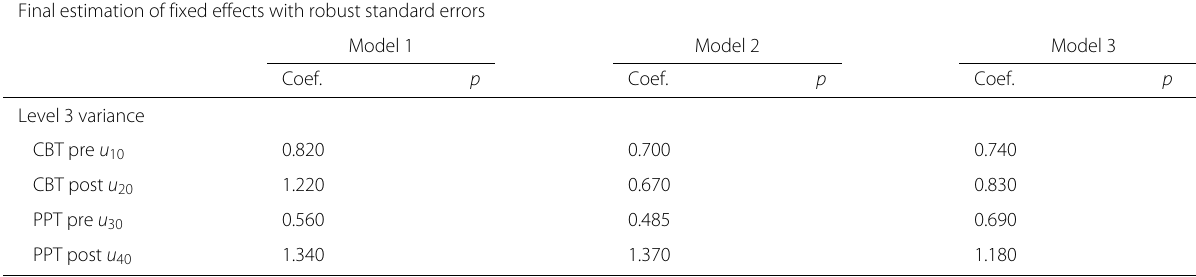
Table 5 HGLMs comparing student participation on the CBT and PPT pretest and posttests ( Continued )